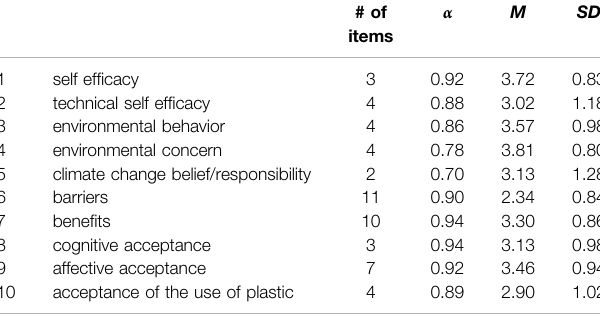
TABLE 1 | Cronbach ’ s α and descriptive statistics for the retained and computed